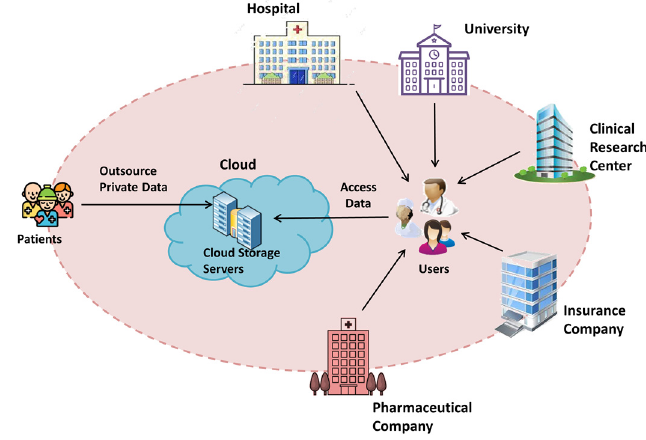
Figure 1. Cloud-based healthcare data sharing.